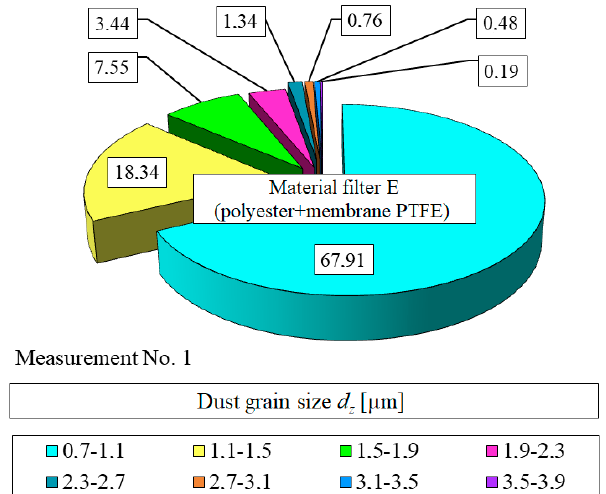
Figure 13. Particle size distribution in the air downstream of the filter element E after reaching the dust mass loading k mA = 5.77 g/m 2 (measurement no. 1).